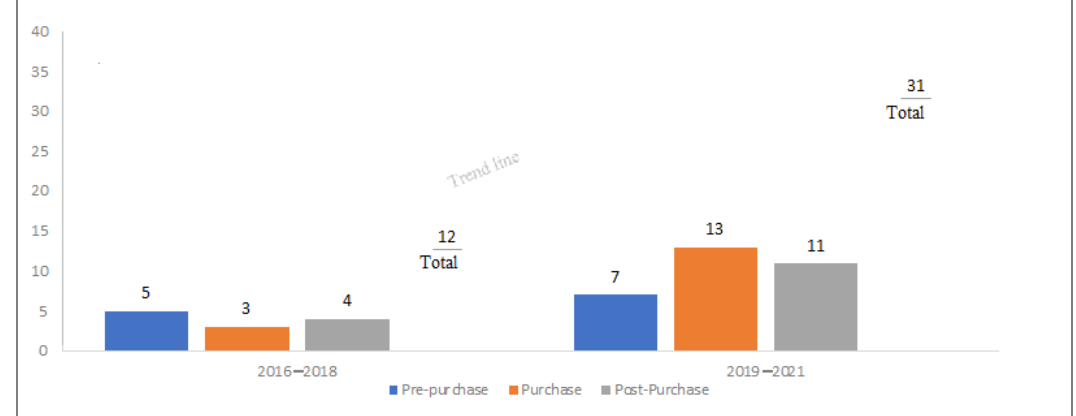
Figure 2. Number of annual publications.